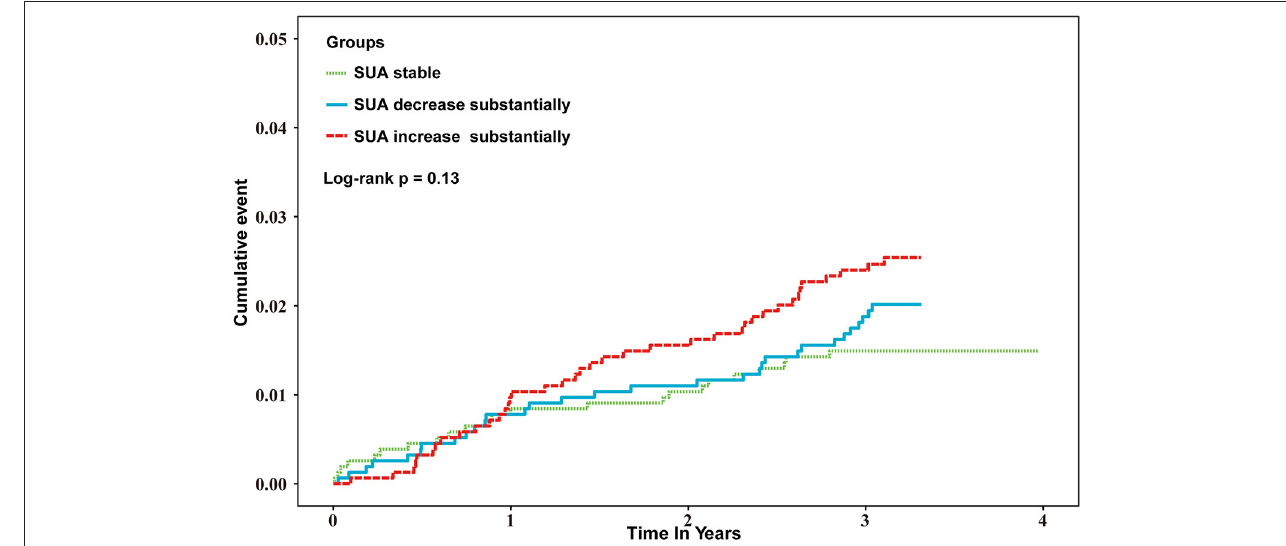
FIGURE 2 | Kaplan–Meier estimates of ischemic stroke-cumulative event by SUA change.